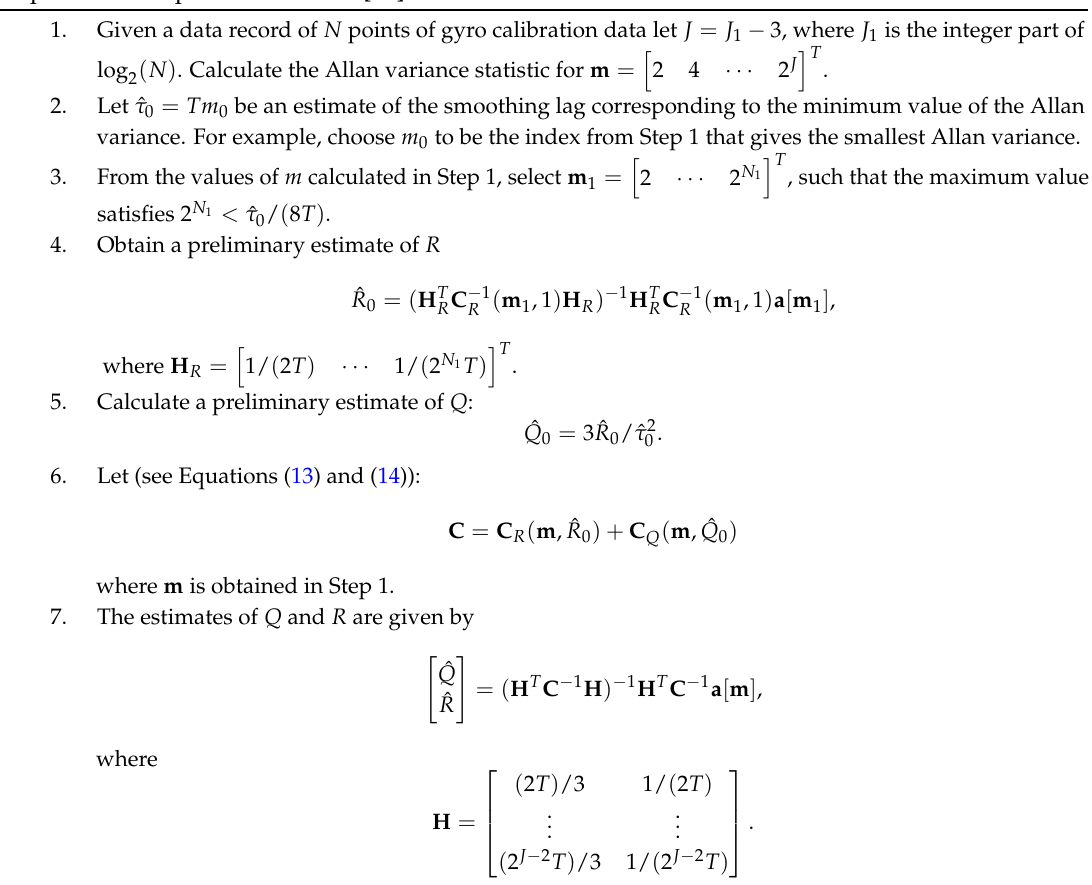
Algorithm 1: An algorithm for estimating individual gyro parameters Q and R . c (cid:13) 2012 IEEE, reprinted with permission from